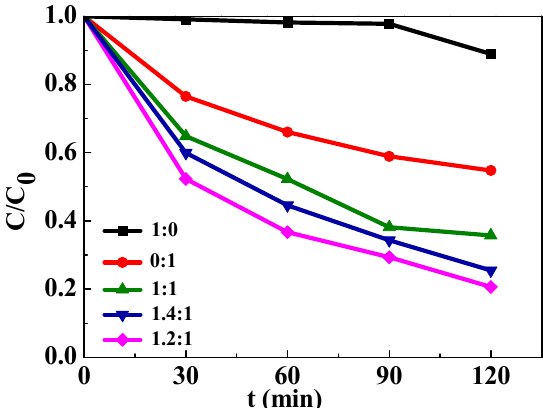
Figure 2. Degradation of RhB as a function of irradiation time in the presence of the as-synthesized BaTiO 3 -TiO 2 core-shell heterostructures and TiO 2 nanoparticles, and the commercial BaTiO 3 crystallines under UV light irradiation. The ratios in Figure are a ratio of BaTiO 3 to TiO 2